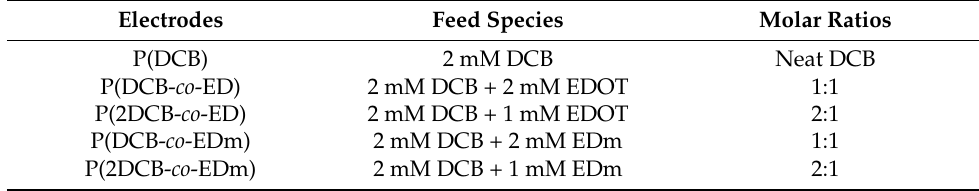
Table 1. Feed species of polymer